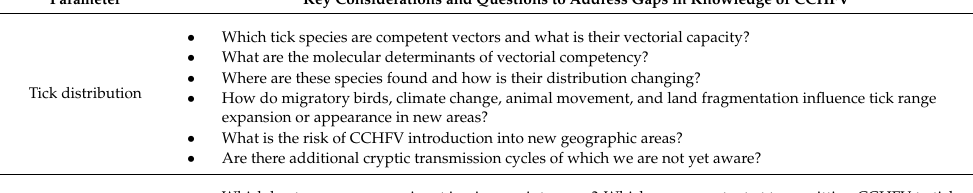
Table 1. Gaps in knowledge of CCHFV and factors contributing to disease. Key considerations and questions regarding parameters of viral maintenance and transmission, including both host and tick factors, that contribute to spillover events (as depicted in Figure 2). These questions aim to highlight areas warranting additional investigation. Reports addressing a subset of these questions currently exist; however, the questions are listed to indicate that more data are required to adequately inform prevention and control e ff